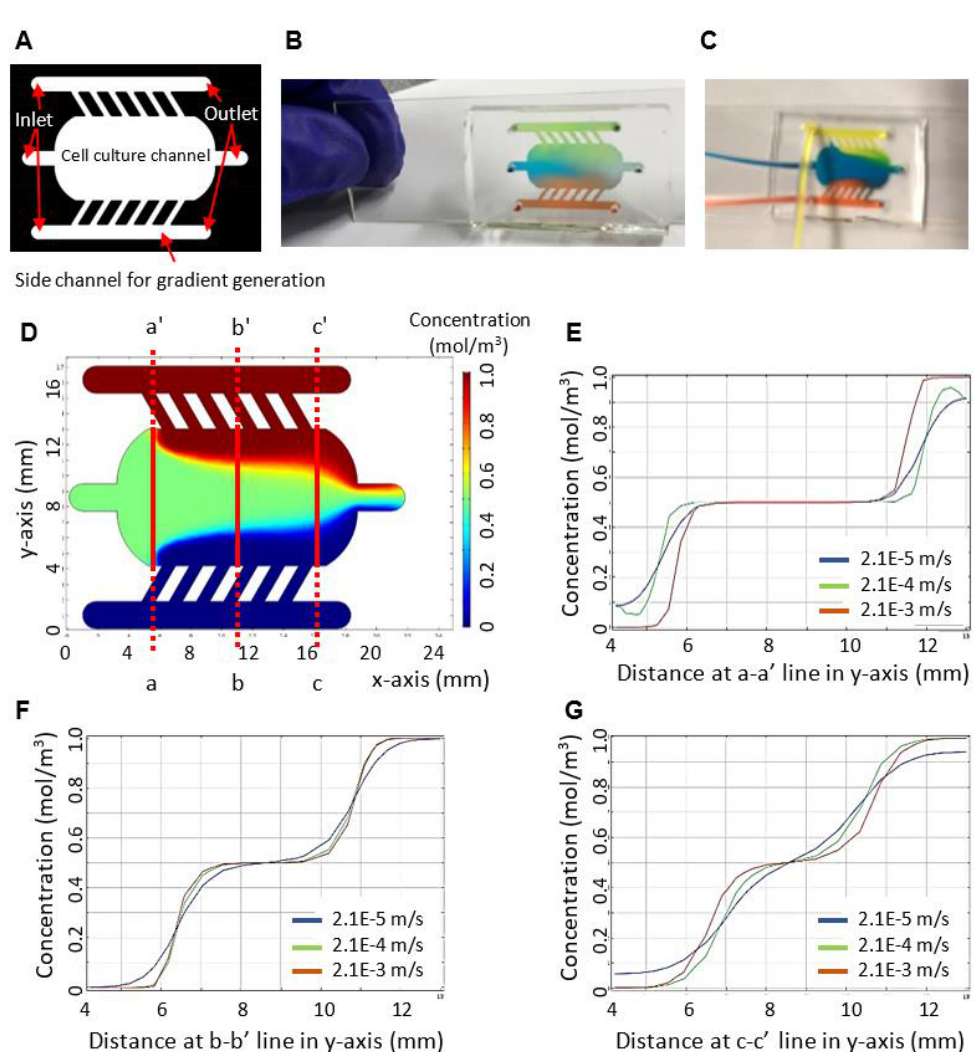
Figure 1. The characterization of the microfluidic device. ( A ) The device consists of a cell culture chamber and side channels for gradient generation. The design of the device allows to co-culture of bacteria and cancer cells. ( B , C ) The functional tests of the device using food dye at static and dy- namic conditions. ( D ) The characterization of a concentration gradient in the gut chip through sim- ulation by COMSOL Multiphysics. A velocity of an inlet is 2.1 × 10 −4 m/s. Diffusion coefficient is 5.4 × 10 −1 0 m 2 /s. Concentrations at one side channel, cell culture chamber, and the other side channel are 1.0, 0.5, and 0 mol/m 3 , respectively. ( E ) The effect of flow rate on a concentration gradient profile along with the crossline a- a’ of the cell culture chamber. ( F ) The effect of flow rate on a concentration gradient profile along with the crossline b- b’ of the cell culture chamber. ( G ) The effect of flow rate on a concentration gradient profile along with the crossline c- c’ of the cell culture chamber.